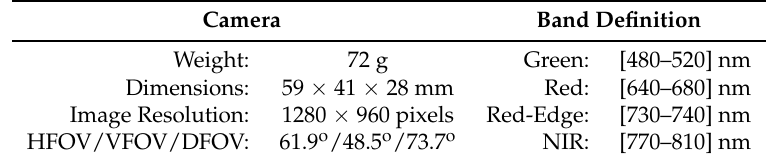
Table 2. Manufacturer technical specifications for the Parrot Sequoia multispectral camera [32]. Camera Band Definition Weight: 72 g Green: [480–520] nm Dimensions: 59 × 41 × 28 mm Red: [640–680] nm Image Resolution: 1280 × 960 pixels Red-Edge: [730–740] nm HFOV/VFOV/DFOV: 61.9 o /48.5 o /73.7 o NIR: [770–810] nm